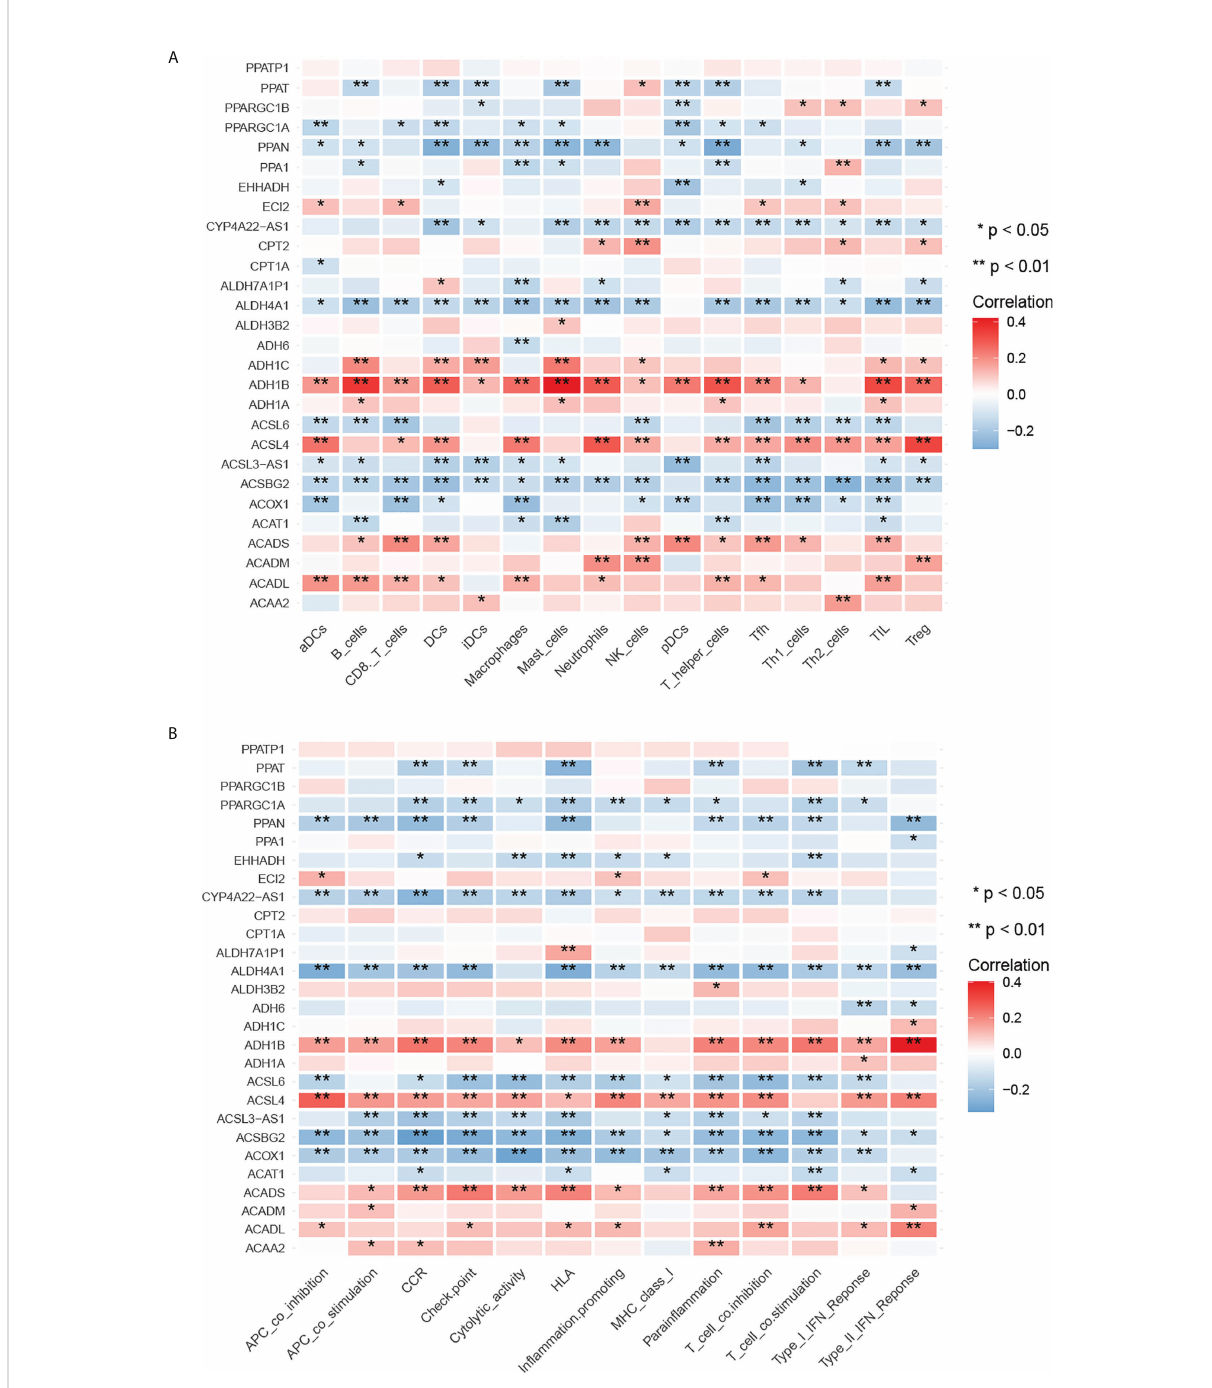
FIGURE 3 Correlation between differentially expressed MMRGs and immune characteristics. (A) Correlation between differentially expressed MMRGs and tumor immune cell in fi ltration; red is positive, blue is negative. (B) Correlation between differentially expressed MMRGs and tumor immune function, red is positive, blue is negative. *p < 0.05; **p <